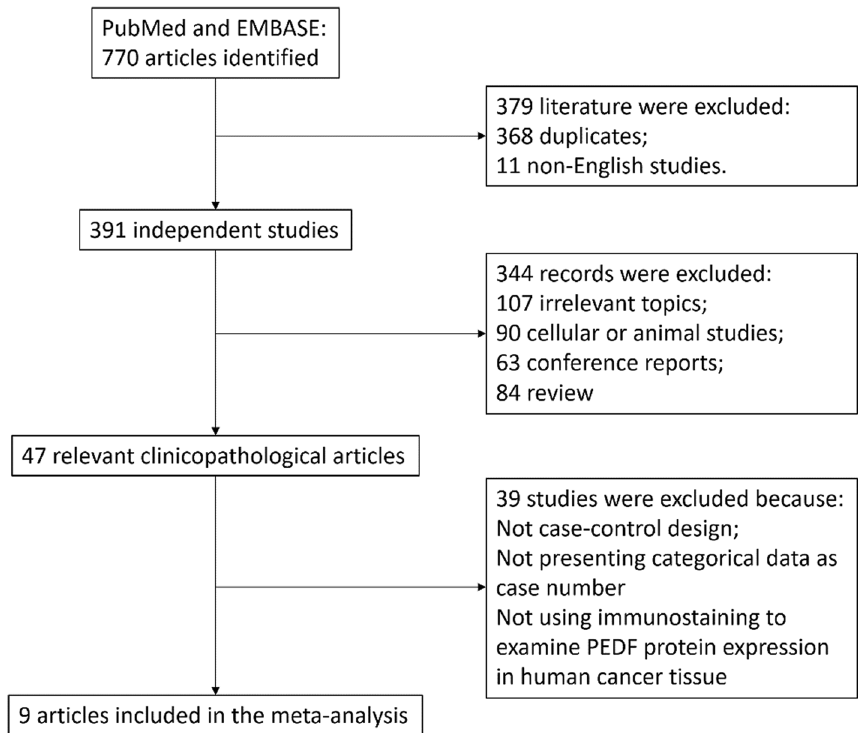
Fig. 1 Flow diagram and results of literature review. The flow diagram depicts the step-wise screening of the retrieved articles from database, including the number and reasons of exclu- sion. A total of 9 studies were selected by this unbiased